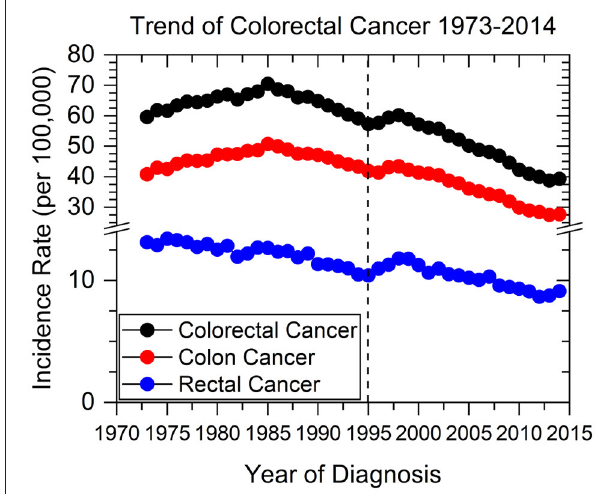
FIGURE 1 | Colorectal, colon, and rectal cancer incidence rates from 1973 to 2014. Dashed line represents when current screening guidelines were recommended in 1995 by the